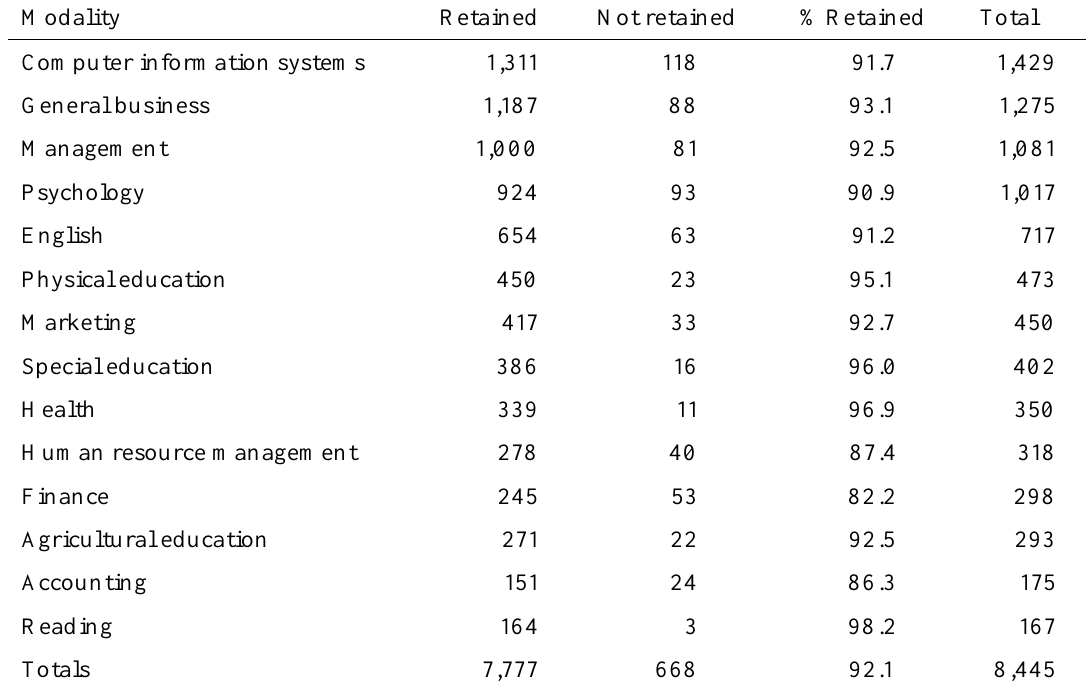
Contingency Table for Course Completion by Course Discipline (N =